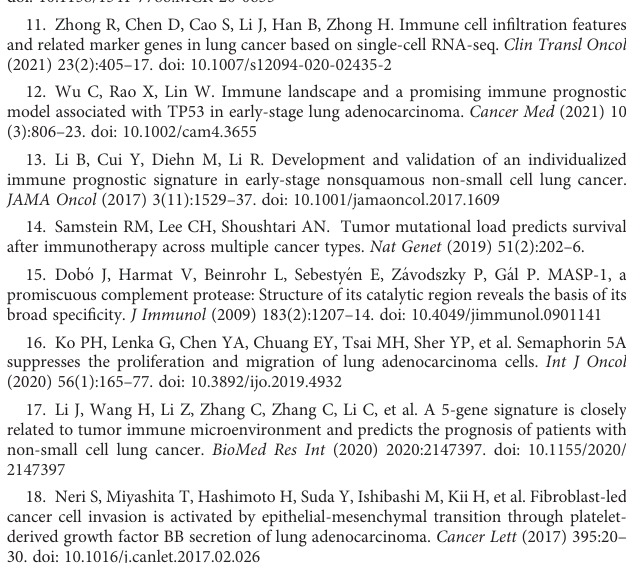
SUPPLEMENTARY FIGURE 1 Scatter plot of correlation between GS and MM gene in turquoise module. SUPPLEMENTARY FIGURE 2 Bubble chart of enrichment analysis, including Biological Process (A) , Cellular Component (B) , Molecular Function (C) and KEGG enrichment pathway (D) . SUPPLEMENTARY FIGURE 3 Genes of mutation rate > 5%. SUPPLEMENTARY FIGURE 4 Correlation analysis of in fi ltrated immune cells. SUPPLEMENTARY FIGURE 5 Construction of multi-factor regulatory network. SUPPLEMENTARY FIGURE 6 (A) Hazard ratio of 15 genes; (B) cross-validation of Lasso-penalized Cox regression analysis; (C) 9 genes for prognostic related risk score model. SUPPLEMENTARY FIGURE 7 Unsupervised clustering classi fi cation based on hub genes. (A) In fl ection point fi gure by elbow algorithm; (B) Heatmapof gene expression in the two subtypes; (C) KM curves between the two clusters. SUPPLEMENTARY FIGURE 8 Expression levels of 44 Immune Checkpoints between the two clusters. SUPPLEMENTARY FIGURE 9 TIDE scores of samples in the two